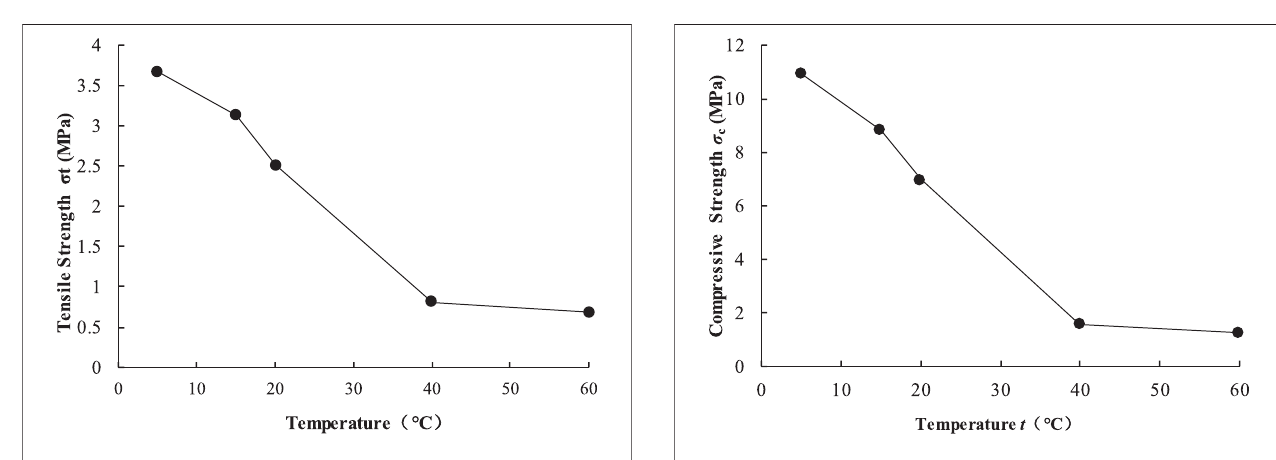
FIGURE 3 | Effect of temperature on tensile strength. FIGURE 4 | Effect of temperature on compressive strength.